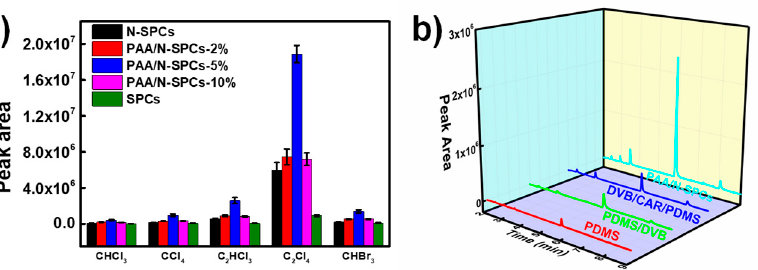
Figure 4. Extraction efficiencies of N-SPCs and PAA/N-SPCs coatings ( a ); GC-MS chromatograms of VHCs by PAA/N-SPCs-5% and commercial SPME coatings ( b ).